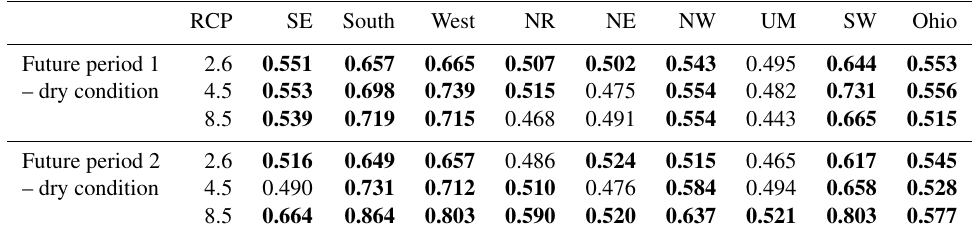
Table 6. The fraction of future dry conditions over all months by RCP trajectory and region (future periods 1 and 2). RCP SE South West NR NE NW UM SW Ohio Future period 1